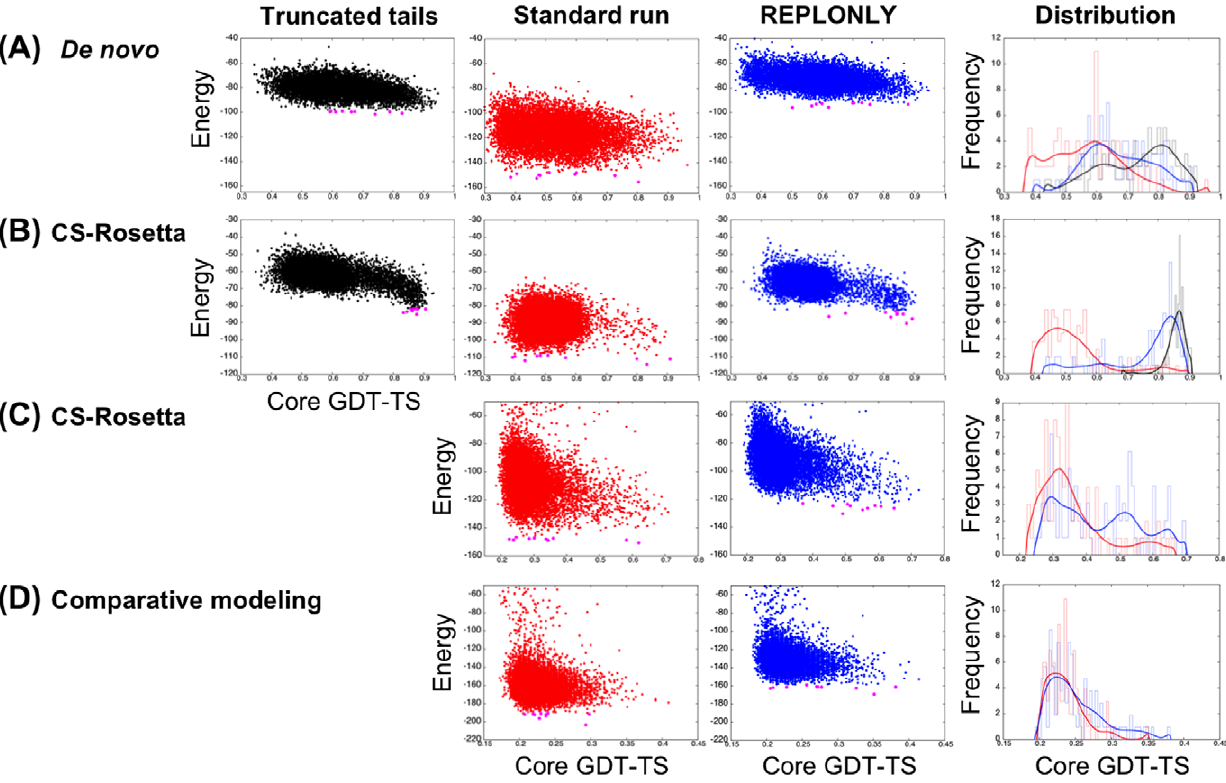
Figure 5. Rosetta modeling with disordered regions treated as REPONLY. ( A ) ab initio (1enh). ( B ) CS-Rosetta (2ae9). ( C ) CS-Rosetta (2k4n). ( D ) Comparative modeling (2k4v). Column 1 to 3. Energy versus core GDT-TS plots. In column 1 ( Truncated tails ) standard Rosetta simulations are carried out with disordered termini removed, in column 2 ( Standard run ) standard Rosetta simulations are carried out including tails/internal loops and in column 3 ( REPLONLY ) the disordered regions contribute only repulsive-related energies during Rosetta structure calculations. The GDT-TS values on the x-axis were calculated from the folded portion of native structure (Table 4). Column 4: Histograms of core GDT-TS of the 1% low-energy models. Black line ‘‘Truncated tails’’ calculations, red line ‘‘Standard run’’ calculations, and blue line ‘‘REPLONLY’’ calculations.